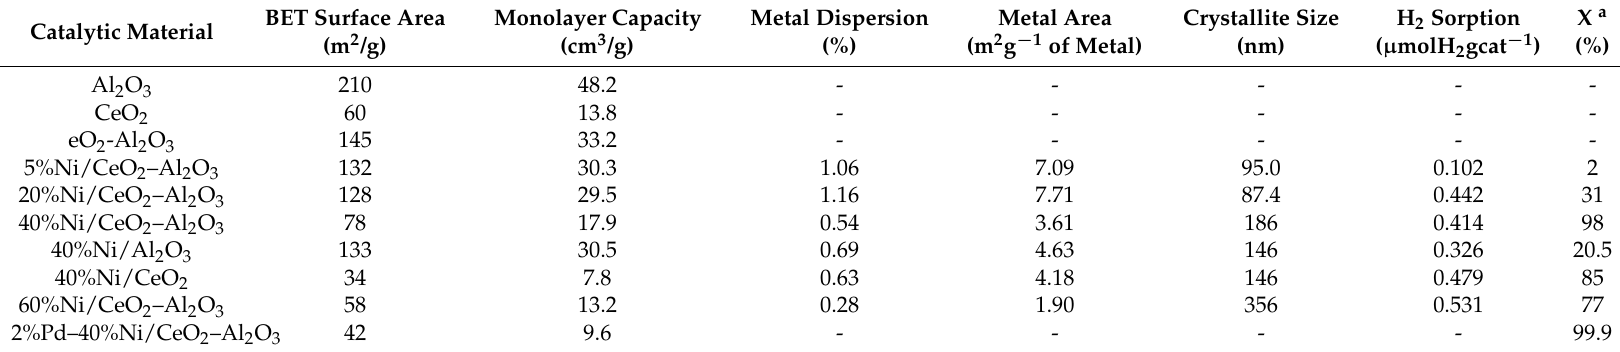
Table 2. Brunauer–Emmett–Teller (BET) surface area, monolayer capacity and dispersion degree of metallic nickel phase of supports and supported nickel catalysts calcined in air atmosphere for 4 h at 400 °C.